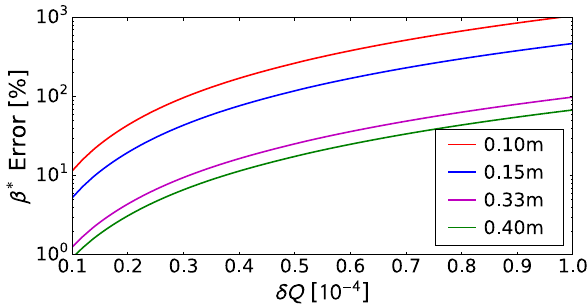
FIG. 8. Error on β (cid:1) measurements versus the tune accuracy for different optics. The error grows rapidly with increasing tune uncertainty. A tune resolution of 5 × 10 − 5 will result in an 120% error on the β (cid:1) measurement for the design optics of β (cid:1) ¼ 0 . 15